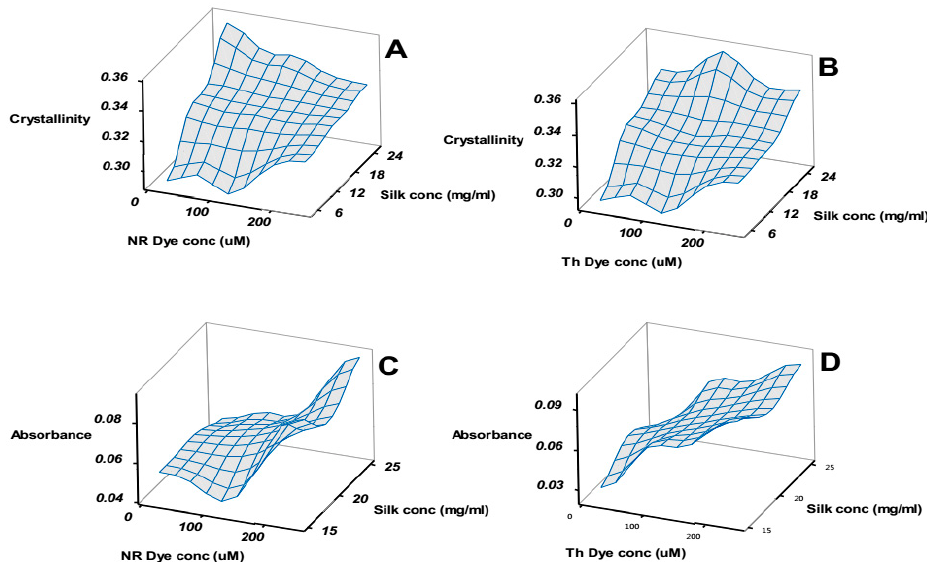
Figure 6. 3D mesh plots of selected responses as a function of factors in factorial design. Panels ( A , B ) compare the patch crystallinity (see materials and methods) for the NR and Th patches respectively; Panels ( C , D ) compare the increase of absorbance from the new peak in NR and Th patches respectively. The success of the patch hinged on a compromise between crystallinity (mechanical integrity) and high absorbance (optimal pH response).